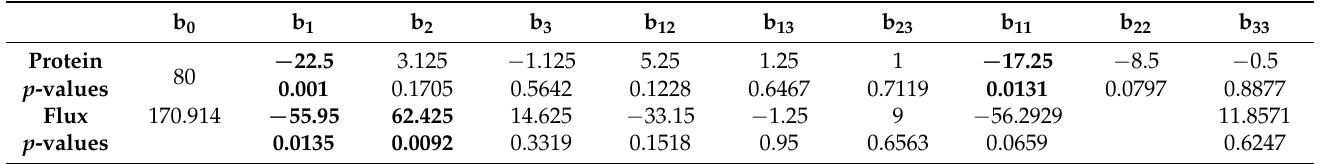
Table 4. Estimated coefficients for responses protein and permeate flux.